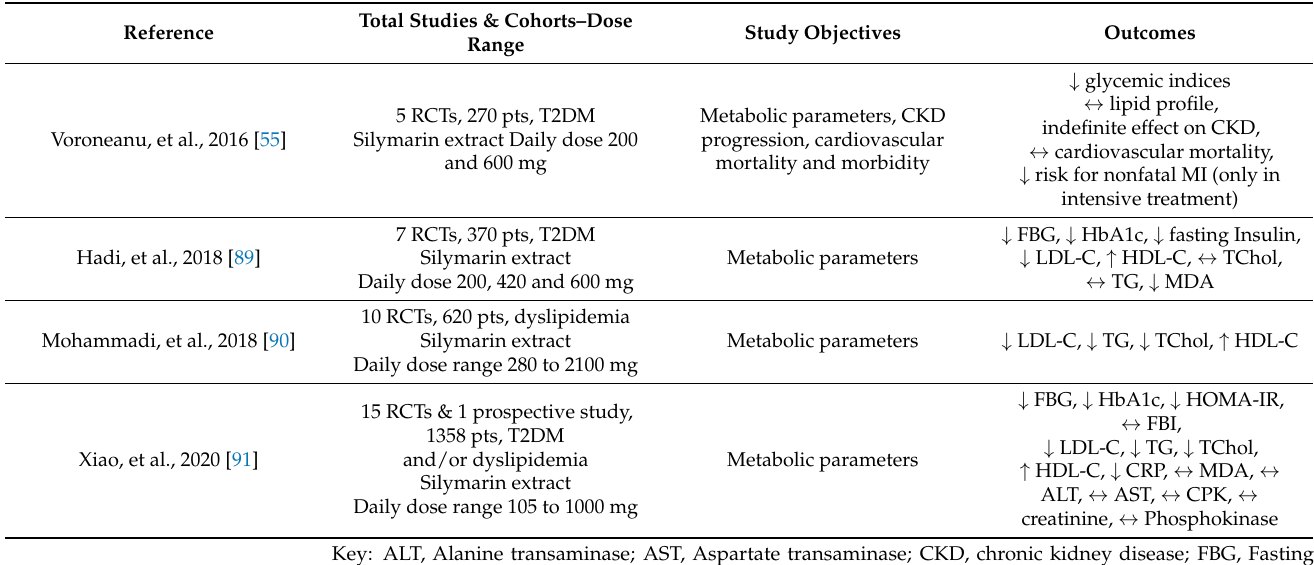
Table 1. Published meta-analysis studies of randomized clinical trials investigating the impact of silibinin/silymarin on classical cardiovascular risk factors.